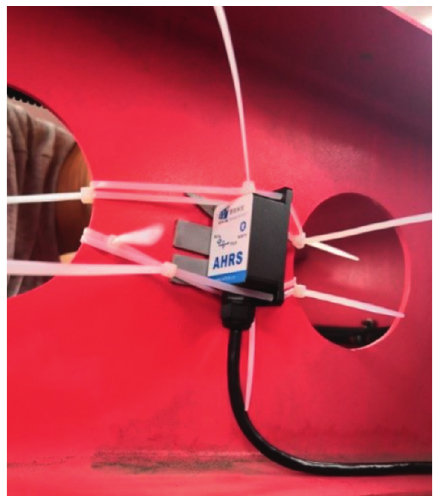
Figure 3: Nine-axis gyroscope